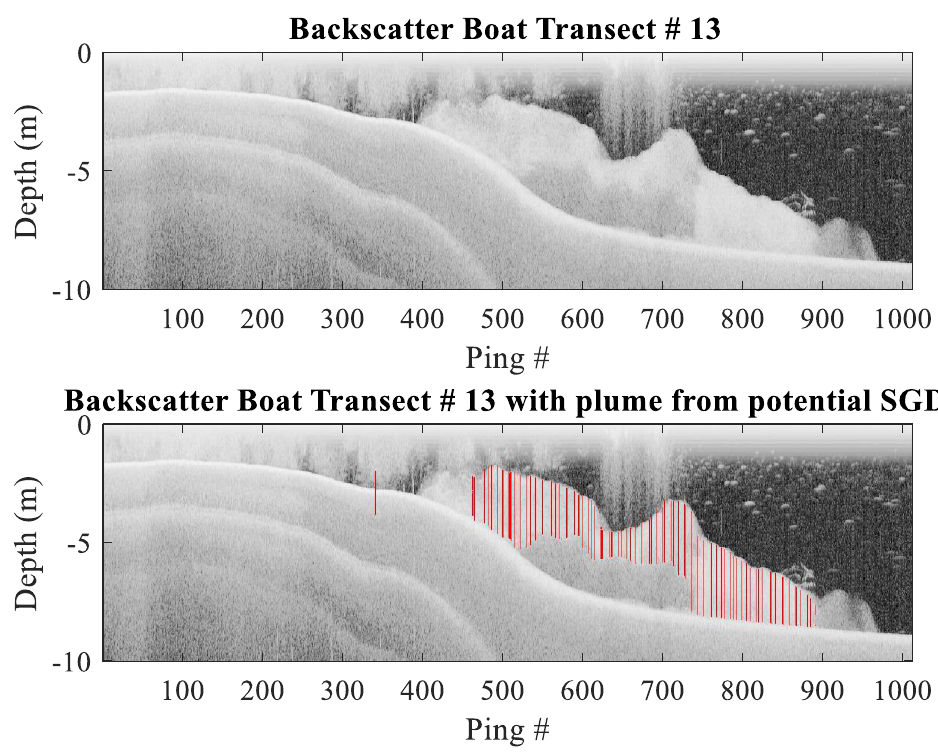
Figure 11. Echograms of sonar transect # 13 referring to transect numbers given in Figure 6; plume from potential SGD is marked in red.